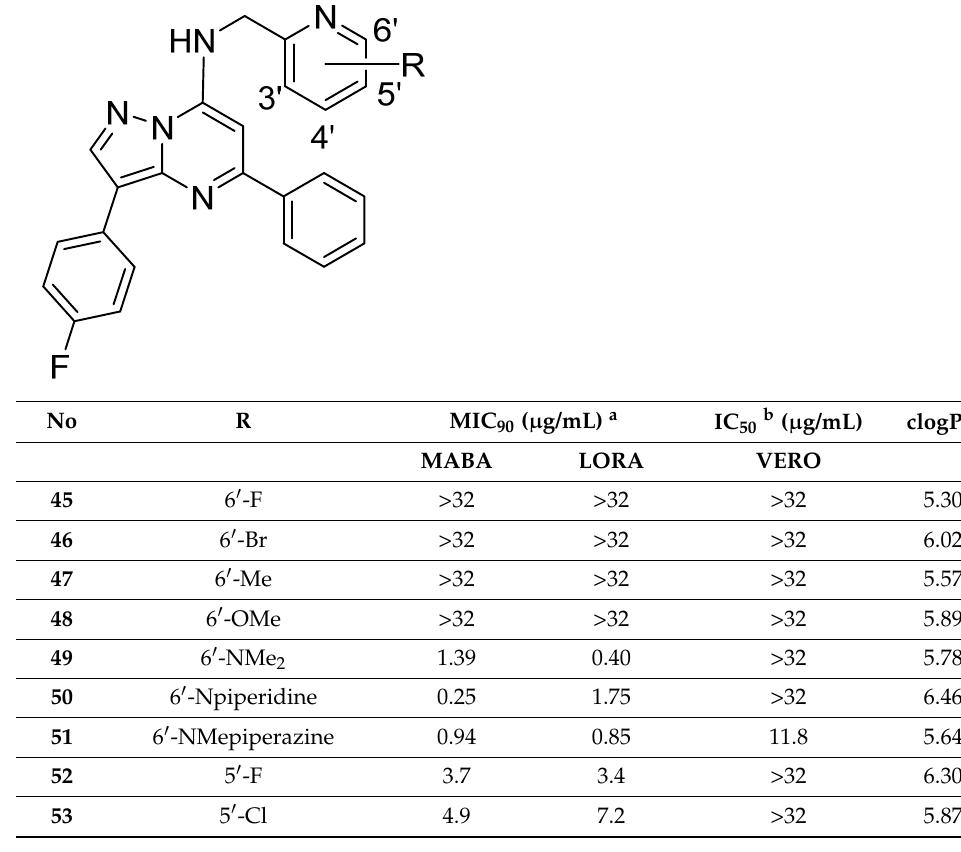
Footnotes for Table 2 As for Table 1. Table 3. Structures and biological data for 7-(2-pyridylmethylamine) ring variations (com- pounds 45–72